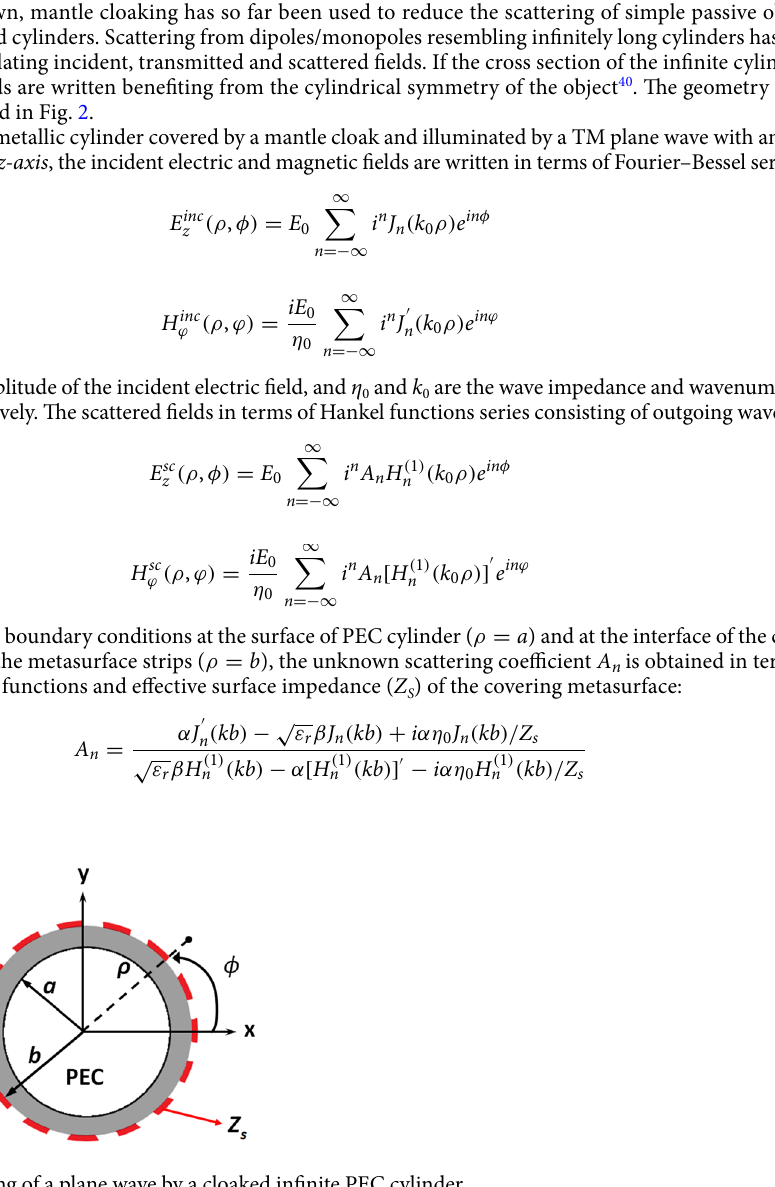
Figure 2. Scattering of a plane wave by a cloaked infinite PEC